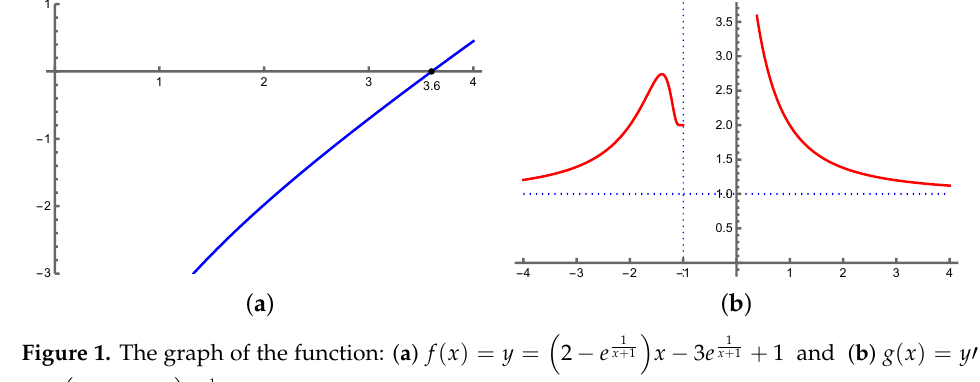
(cid:17) (cid:16) x − 3 e 1 x + 1 + 1 and ( b ) g ( x ) = y (cid:48) = 2 − e 1 x + 1